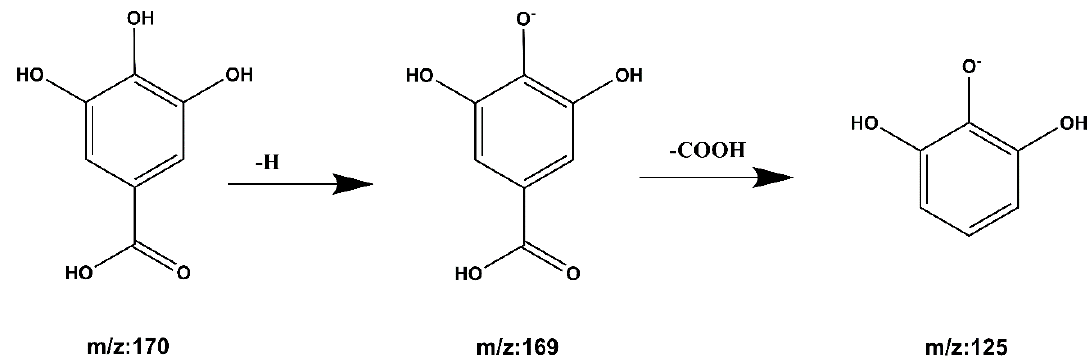
Figure 9. Gallic acid cleavage pathway by mass spectrometry Compound 4 Vanillic acid: The quasi-molecular ion peak was detected at [M − H] − m / z 167 with a retention time of 11.22 min. After removal of de – COOH and CH 3 , m / z 167 is fragmented into m / z 123, – CH 2 removed at m / z 152, m / z 123 produces fragment m / z 109, loss of – H at m / z 109 produces fragment m / z 108; loss of – COOH at m / z 152 produces fragment m / z 108. The cracking process is shown in Figure 10. When compared to the Mass Bank database and reference papers [31,32], it is speculated that the compound is vanillic acid. Figure 10. Vanillic acid cleavage pathway demonstrated by mass spectrometry Compound 5 Ferulic acid: The quasi-molecular ion peak was detected at [M − H] − m / z 193.05, and the chromatographic retention time was 13.4 min. Consequently, m / z 193.05 produces fragments m / z 177 and m / z 149 after the removal of H 2 O and CH 2 O 2 . The loss of CH 3 at m / z 149 results in fragment m / z 134. The cracking process is shown in Figure